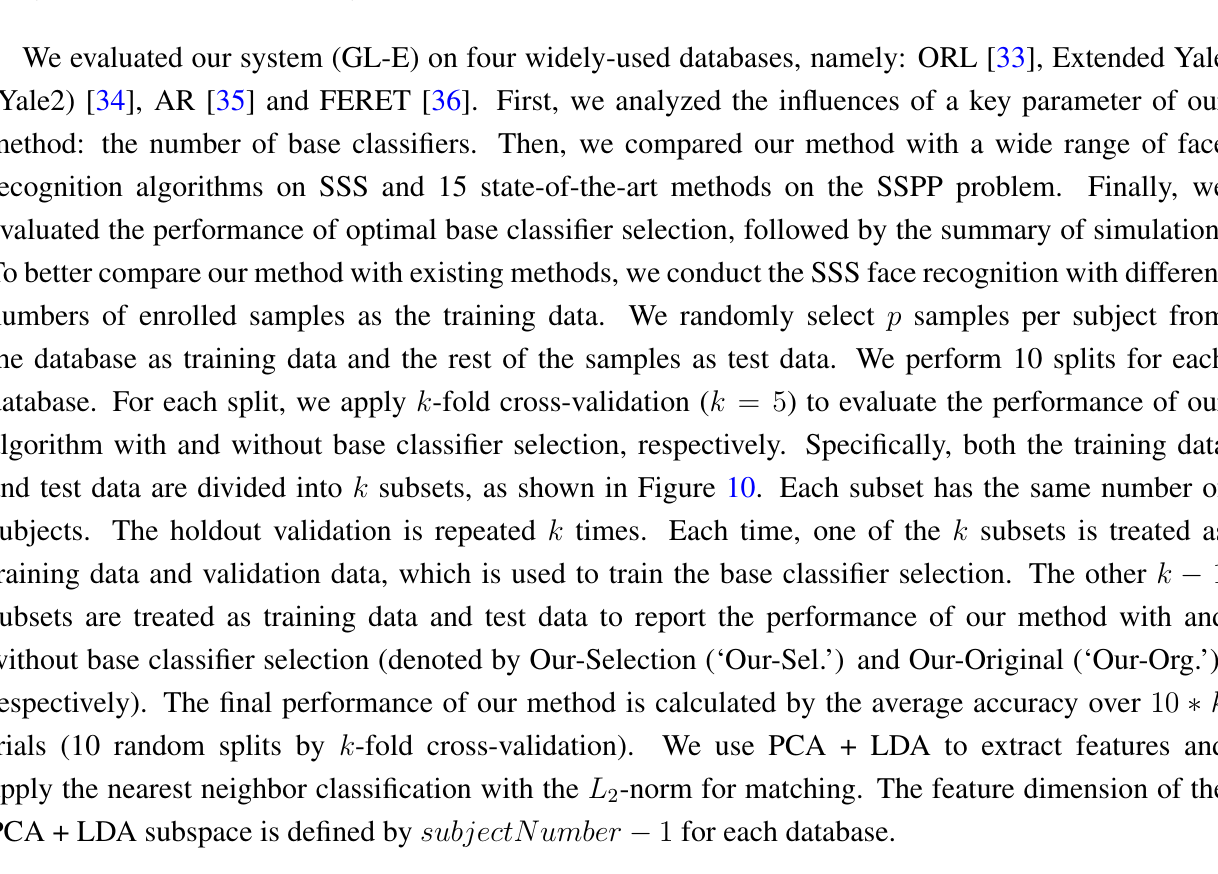
Figure 10. k -fold cross-validation for system performance